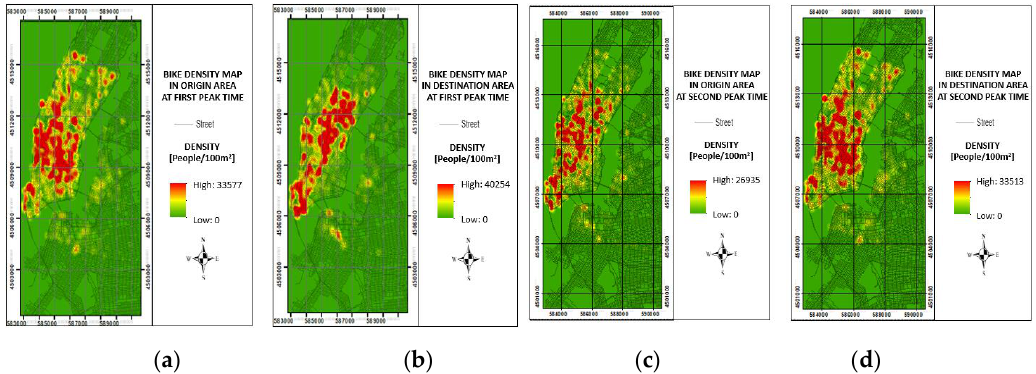
Figure 6. Bike density maps during weekday peak times:( a ) origin density map at 08:00 – 09:00; ( b )